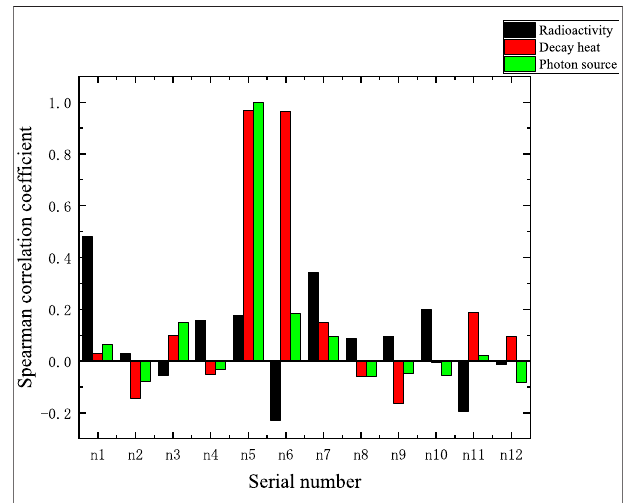
FIGURE 7 | Spearman ’ s correlation coef fi cient of input and output parameters at 10th